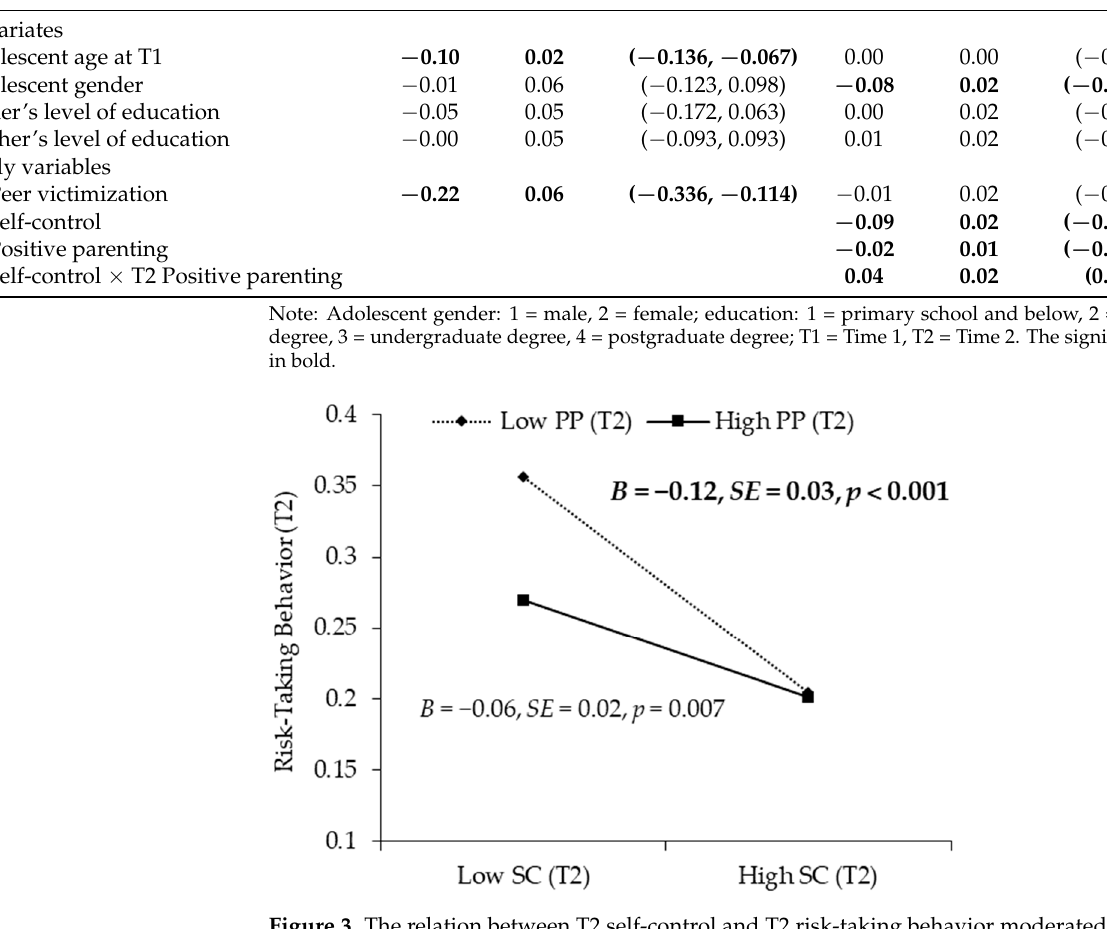
Table 4. Conditional indirect effects of T1 peer victimization on T2 risk-taking behavior via T2 self- control by levels of T2 positive parenting.